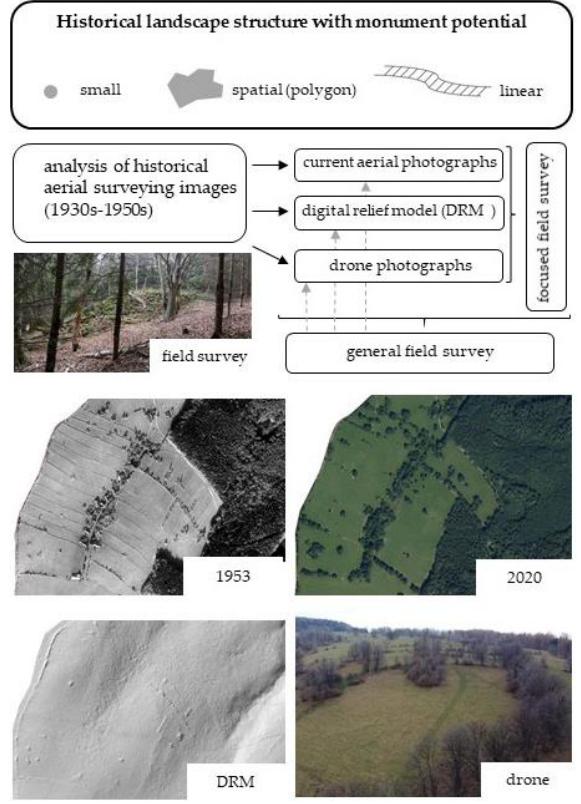
Figure 4. Scheme of methodical procedure.